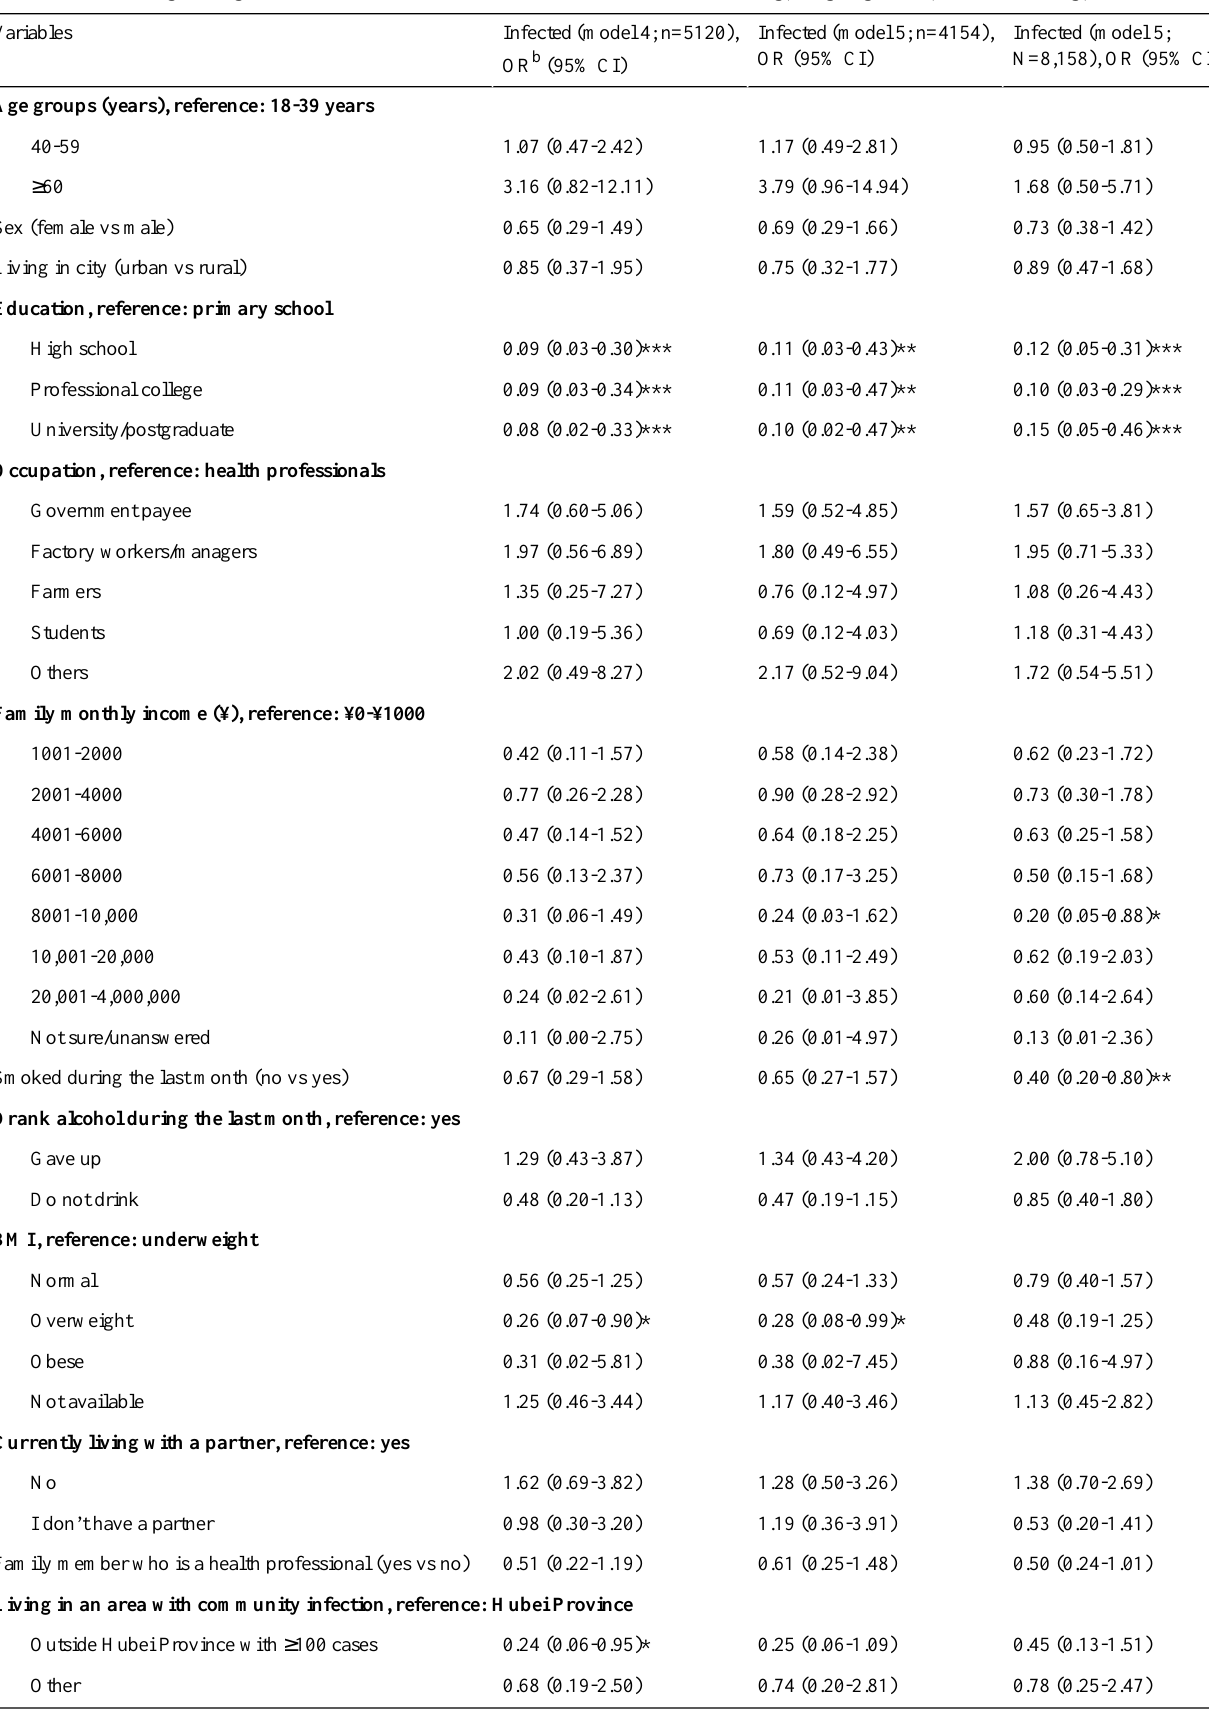
Table 7. Penalized logistic regression model results for COVID-19 infection and handwashing, coughing habits, social distancing, and mask wearing. a